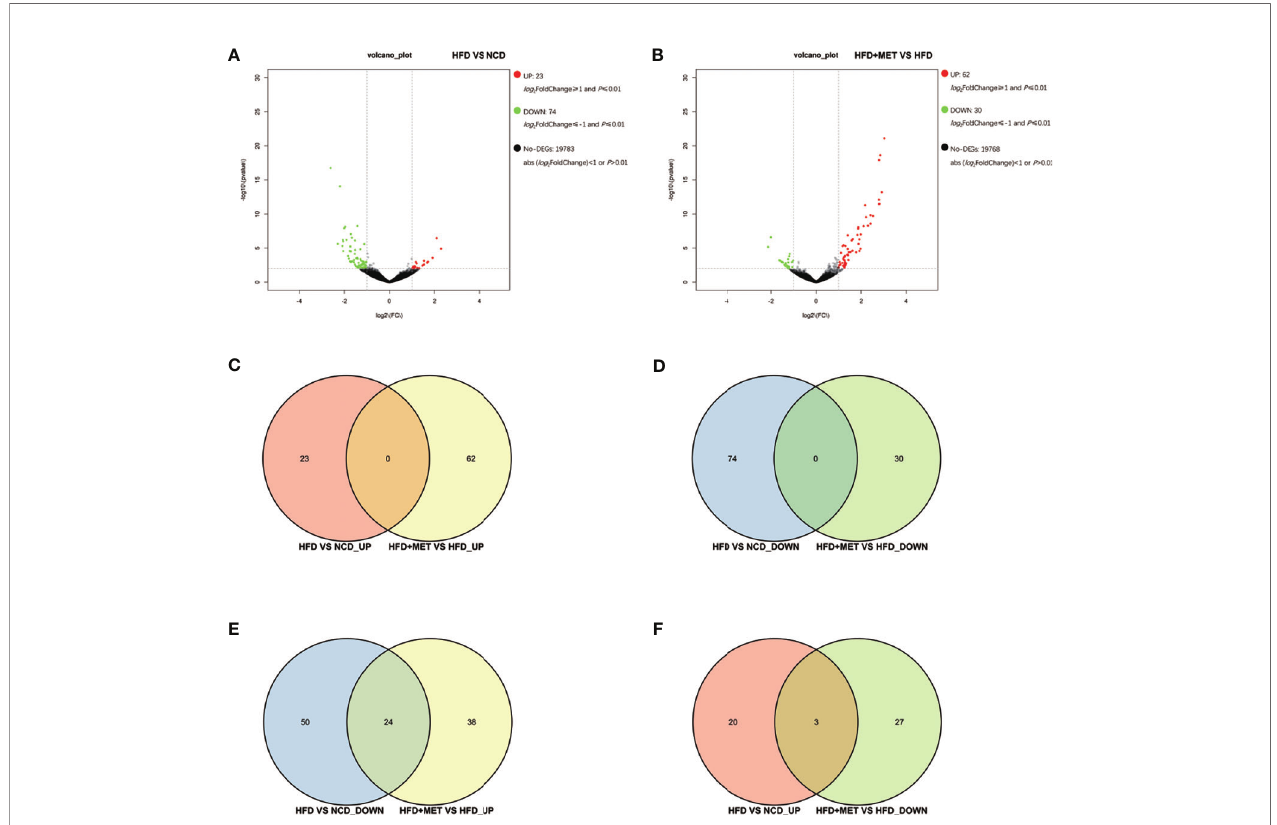
FIGURE 4 | Differentially expressed genes (DEGs) analysis in colon. The volcano plot showed distribution pattern of DEGs in the comparison of HFD vs NCD (A) and HFD+MET vs HFD (B) . Venn diagram of upregulated common DEGs (C) and downregulated common DEGs (D) in two comparisons of HFD vs NCD and HFD+ MET vs HFD. Venn diagram of common DEGs showing opposite expression changes in two comparisons of HFD vs NCD and HFD+MET vs HFD (E, F) . Red color or positive number indicates upregulation, and green color or negative number indicates